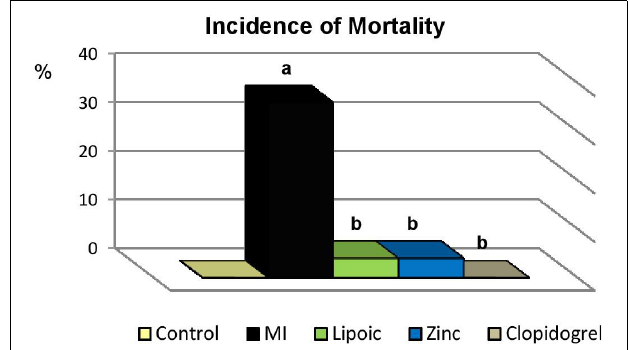
FIGURE 2 | Incidence of mortality in the control, untreated myocardial infarction (MI) and pre-treated (lipoic acid, zinc sulfate and clopidogrel) groups. Significance of differences is calculated by χ 2 -test at p < 0.05; a—vs. controls, b—vs. MI group.